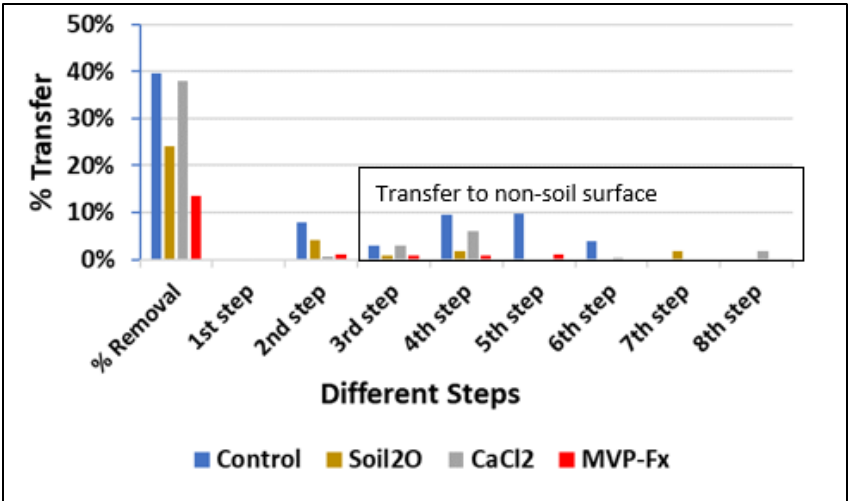
Figure 15. Percent Transfer for Walking Experiment on the Sand Walking Path.